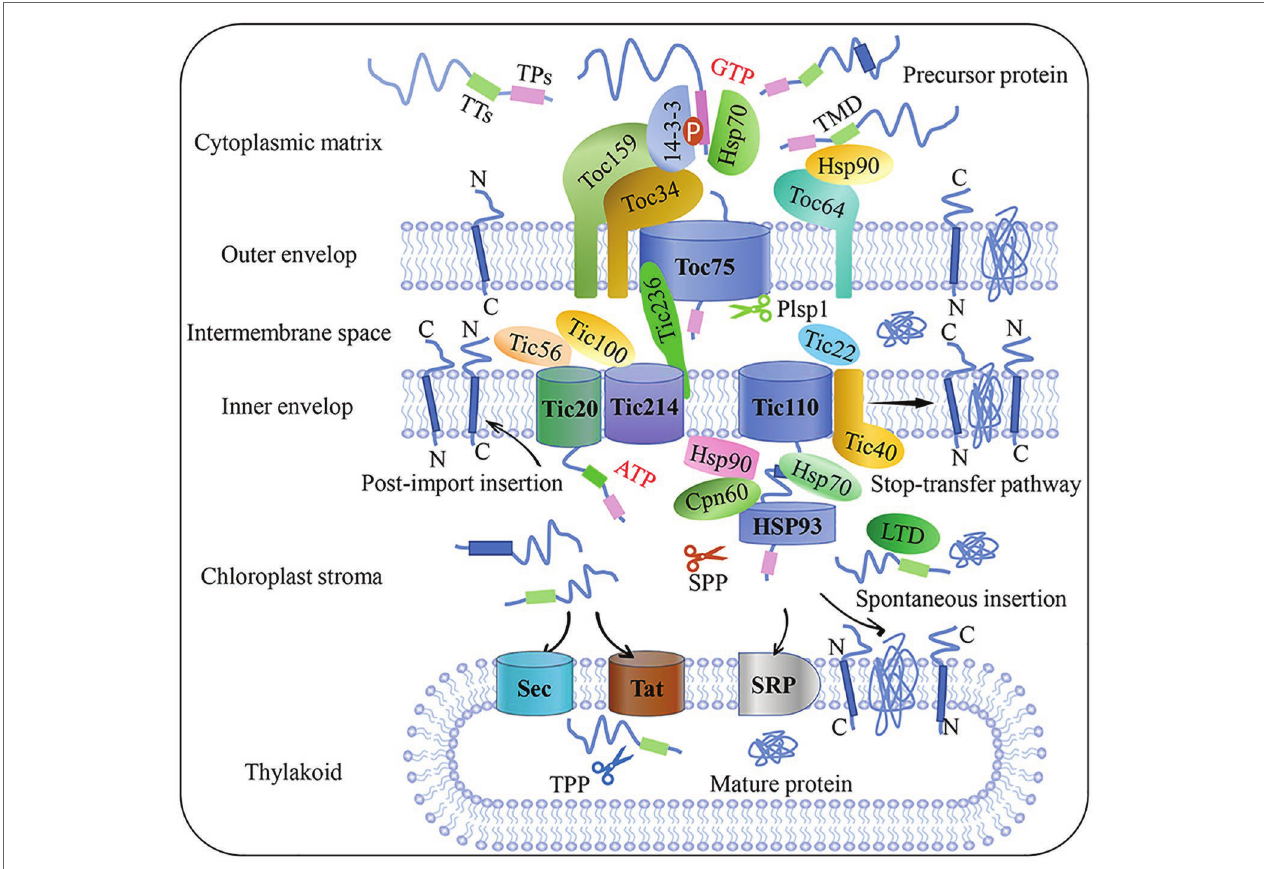
FIGURE 1 | Flow chart of plant chloroplast protein import. Precursor protein entered the intermembrane space through the Toc complex after recognition by the guidance complex. With the aid of molecular chaperones and stroma processing peptidase, precursor protein is then translocated into the chloroplast stroma through the Tic complex. Preproteins target the inner membrane through post-import insertion and stop-transfer pathways. Preproteins can also be inserted into the thylakoid membrane through SRP or spontaneous insertion and translocation across the thylakoid membrane through the Sec and Tat complex, respectively. Plsp1: plastid type I signal peptidase 1; Sec: secretion; SPP: stromal processing peptidase; SRP: signal recognition particle; Tat: twin-arginine translocation; Tic: translocon at the inner envelope membrane of chloroplasts; TMD: transmembrane domain; Toc: translocon at the outer envelope membrane of chloroplasts; TPs: transit peptide sequence; TTs: thylakoid targeting